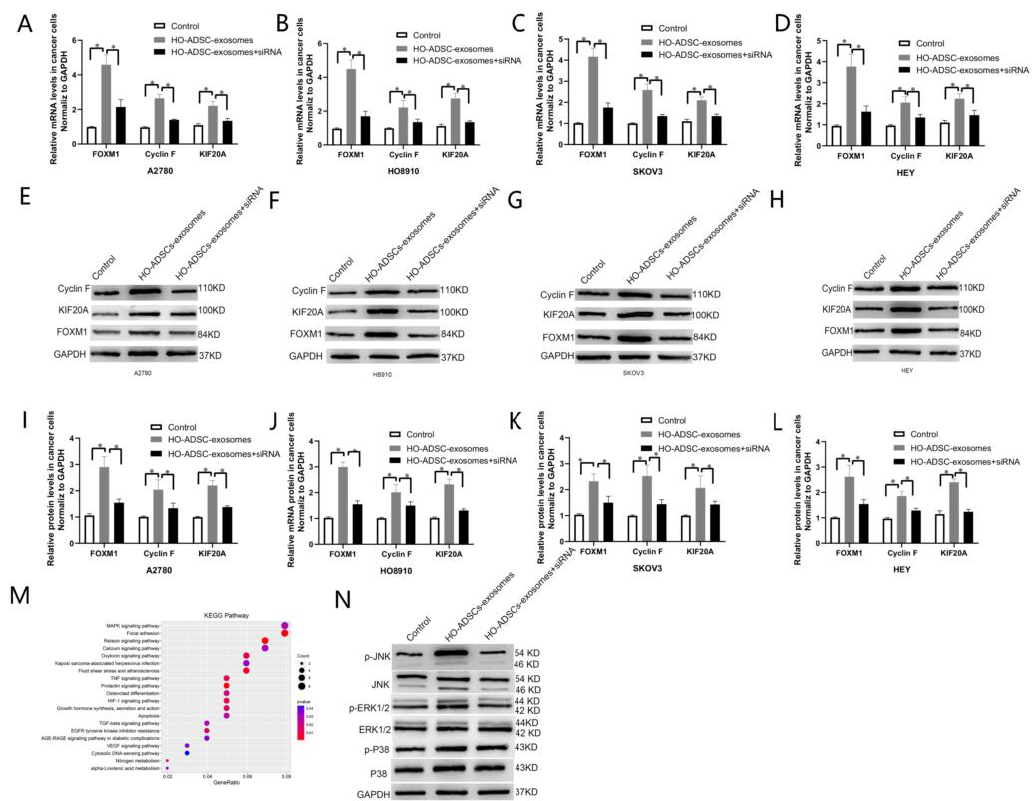
Figure 7. FOXM1 regulated HO-ADSC-exosome-mediated EOC progression by targeting Cyclin F and KIF20A. ( A – D ). FOXM1, Cyclin F, and KIF20A mRNA expression in A2780, HO8910, SKOV3, and HEY cells was determined by qRT‒PCR. ( E – H ). FOXM1, Cyclin F, and KIF20A protein expres- sion in A2780, HO8910, SKOV3, and HEY cells were measured using Western blot assays after FOXM1 knockdown . ( I – L ). Densitometric quantification of FOXM1, Cyclin F, and KIF20A expres- sion in A2780, HO8910, SKOV3, and HEY cells after FOXM1 knockdown. ( M ). KEGG pathway en-